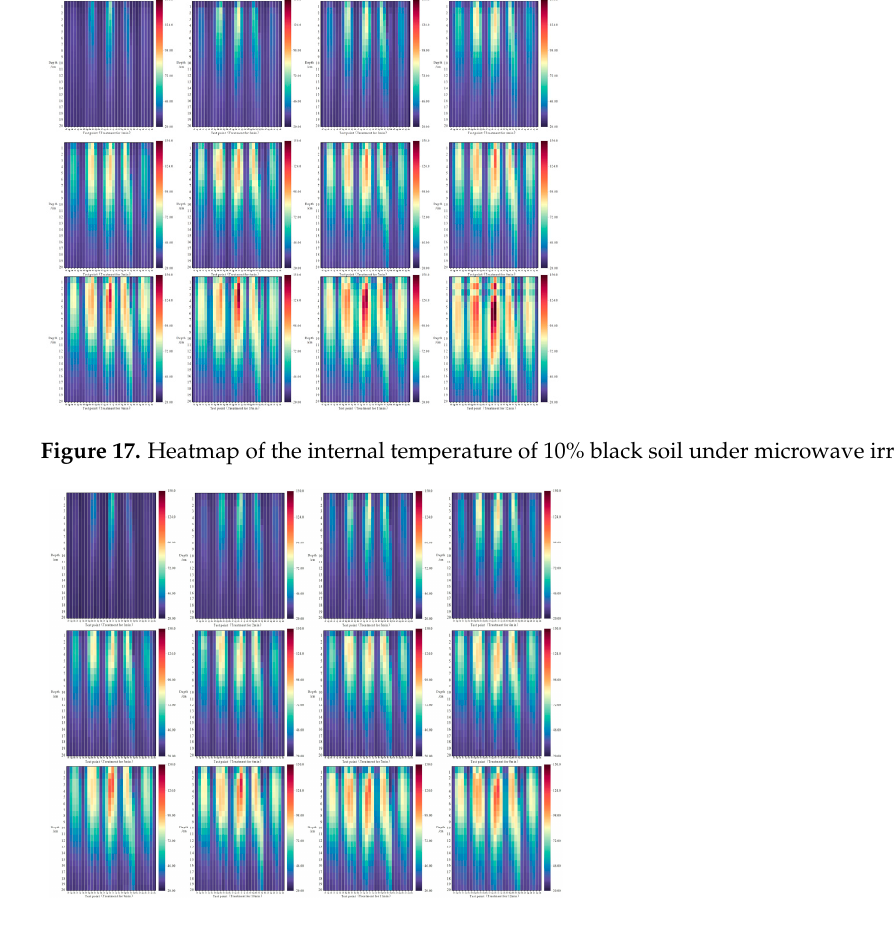
Figure 18. Heatmap of the internal temperature of 15% loess under microwave irradiation.